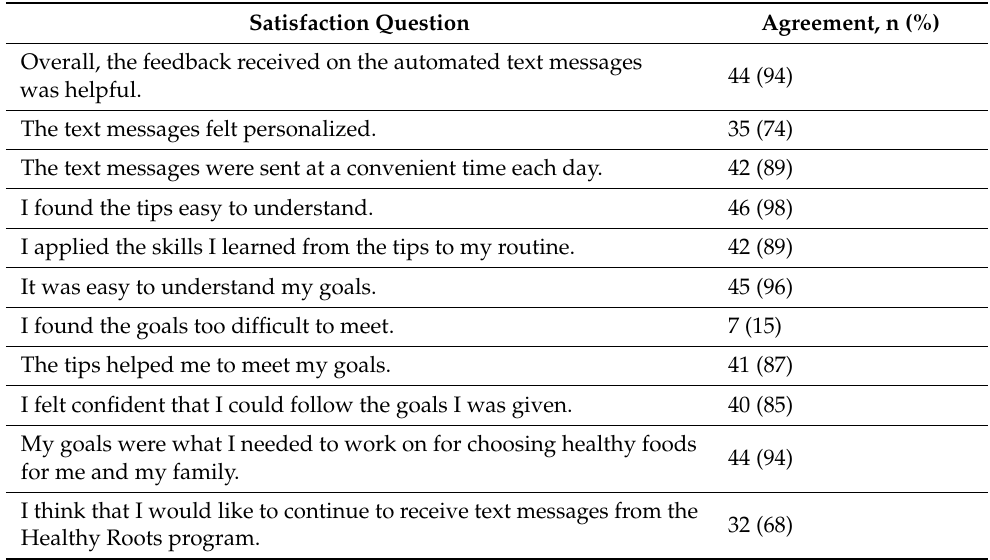
Table 5. Perceived usefulness and ease of use of intervention components among participants receiving the Healthy Roots intervention (n =